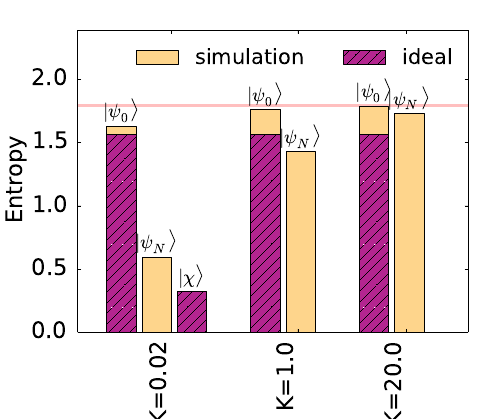
Figure 3: The von Neumann entropy S ( t = 10 ) extracted from Fig. 2 (indicated by simulation) compared to entropy for the mixed-state that corresponds to pure dephasing in the compu- tational basis (marked by ideal). The simulations have been carried out for a central-system = 4 particles strongly coupled ( I = 20 J of N ) to N (cid:69) = 16 environment particles via ran- S S dom antiferromagnetic Ising coupling. The initial state of the CS and the intra-environment strength (in units of J ) are indicated in the panel. For initial state | χ 〉 the simulation and S ideal entropy exactly coincide and are identical for all three K values ( K = J and K = 20 J S S 〉 is zero. have been omitted in the figure). The ideal entropy for state | ψ N